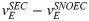
Ephaptic field.For one particular axon, randomly chosen as an example, central panel shows the time evolution of the extracellular potential (vE) on the node of Ranvier lying closer to the electrode’s active pad for both simulations (blue for SNOEC, black for SEC), and left panel shows the time evolution of the transmembrane potential (vm, same location and legend). Note in this panel how the EC produces an AP earlier than in SNOEC. Right panel: Time evolution of the endogenous fields (vESEC−vESNOEC) for all the axons (thin black lines) on the nodes lying closer to the active pad. Red lines indicate the mean of these fields (averaged for each time step, middle thick line) with their standard deviation (thin lines). The two black vertical lines indicate the start and finish of the pulse.